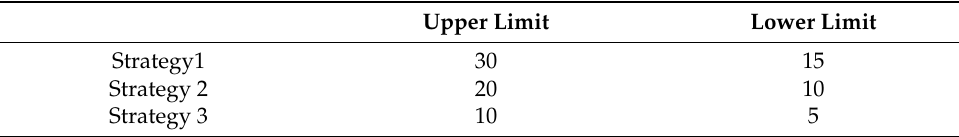
Table 3. Upper and lower limits of aggregation nodes in each